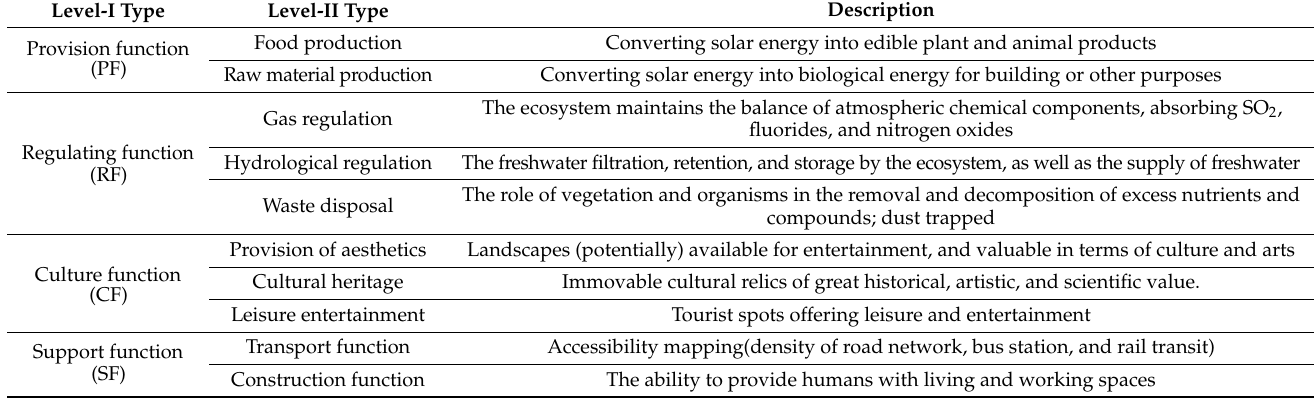
Table 1. The description of landscape